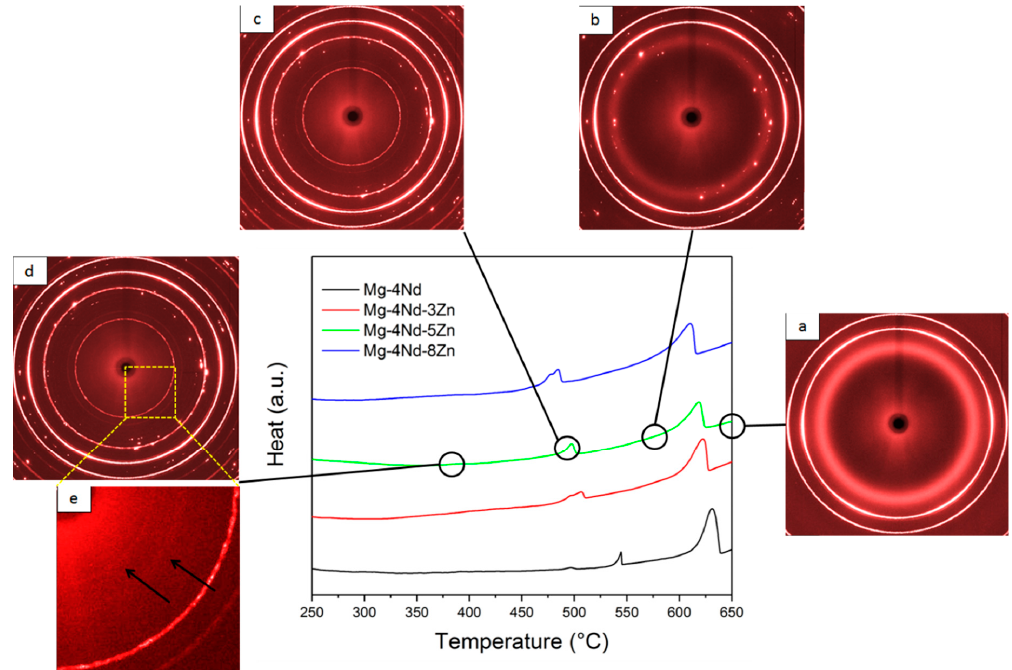
Figure 2. DTA curves of the samples obtained during solidification and the corresponding diffraction patterns of Mg-4Nd-5Zn in ( a ) fully liquid; ( b , c ) semi solid and ( d , e ) fully solid state, obtained by in situ synchrotron radiation diffraction.